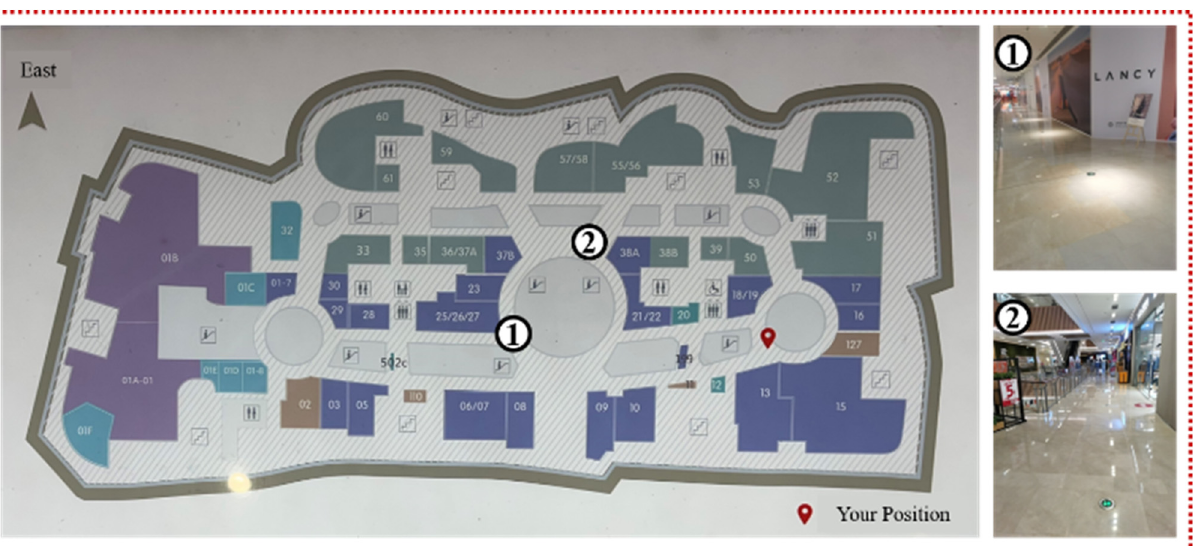
Figure 7. Schematic diagram of the shopping mall.